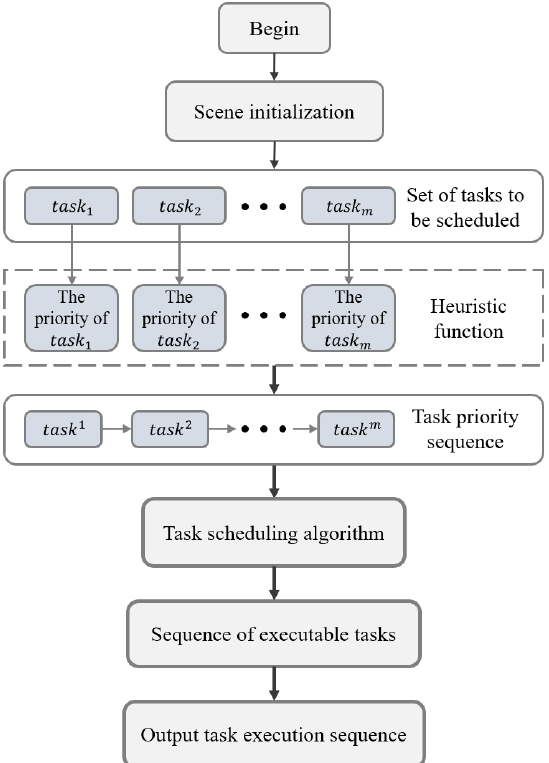
Figure 2. Traditional heuristic algorithm flow diagram of static parameter